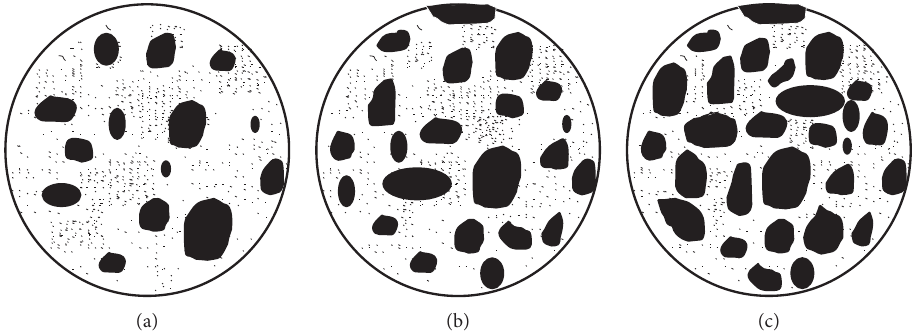
Figure 6: Composition diagrams of sand and cobble soil with different CCs. (a) Suspension compact structure. (b) Skeleton-pore structure. (c) Dense skeleton structure.